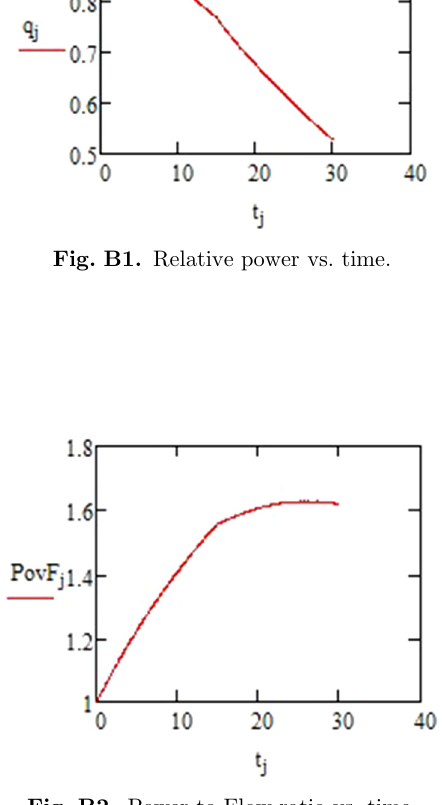
Fig. B2. Power-to-Flow ratio vs. time.